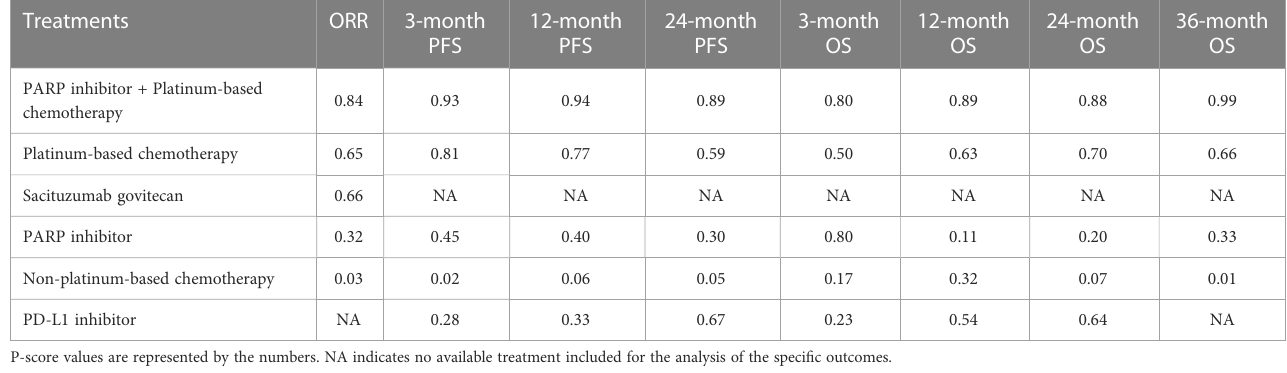
TABLE 3 Network rankings of ef fi cacy outcomes by p-score.